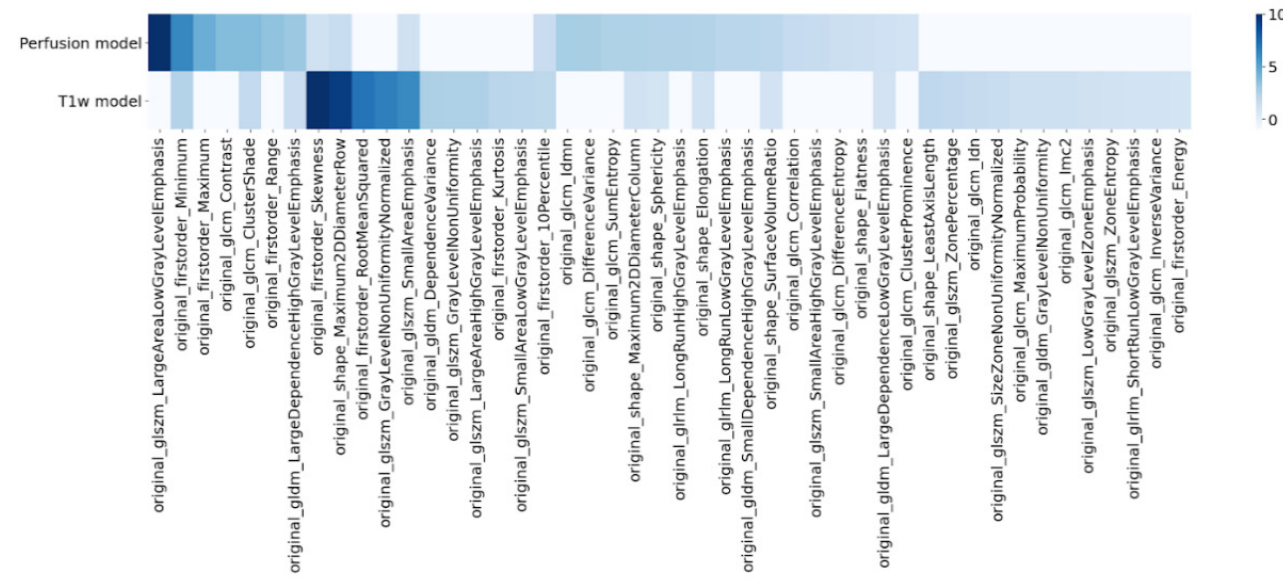
Figure 6. Selected features for the two best radiomics models dedicated to the detection of radionecrosis: perfusion-based model (top) and T1w-based model (bottom). Regarding the T1w-